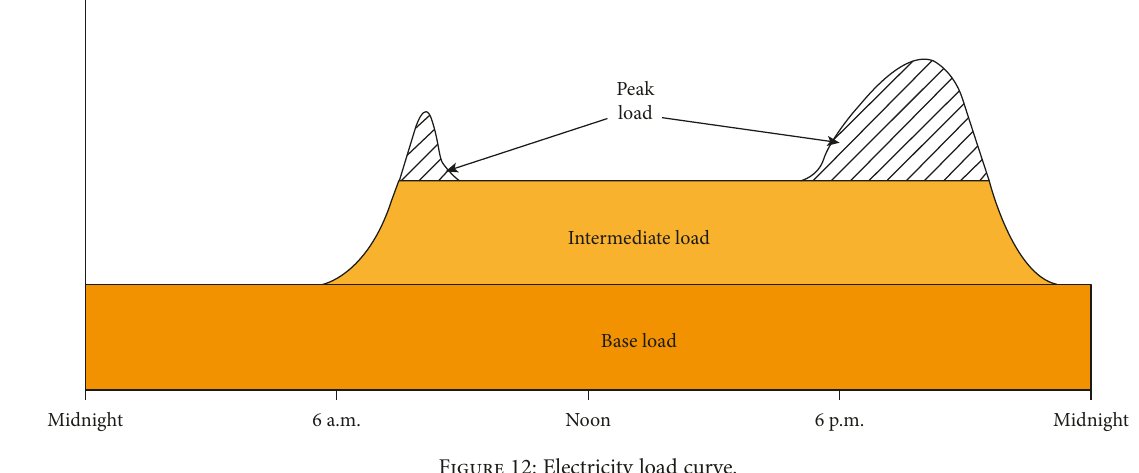
Figure 12: Electricity load